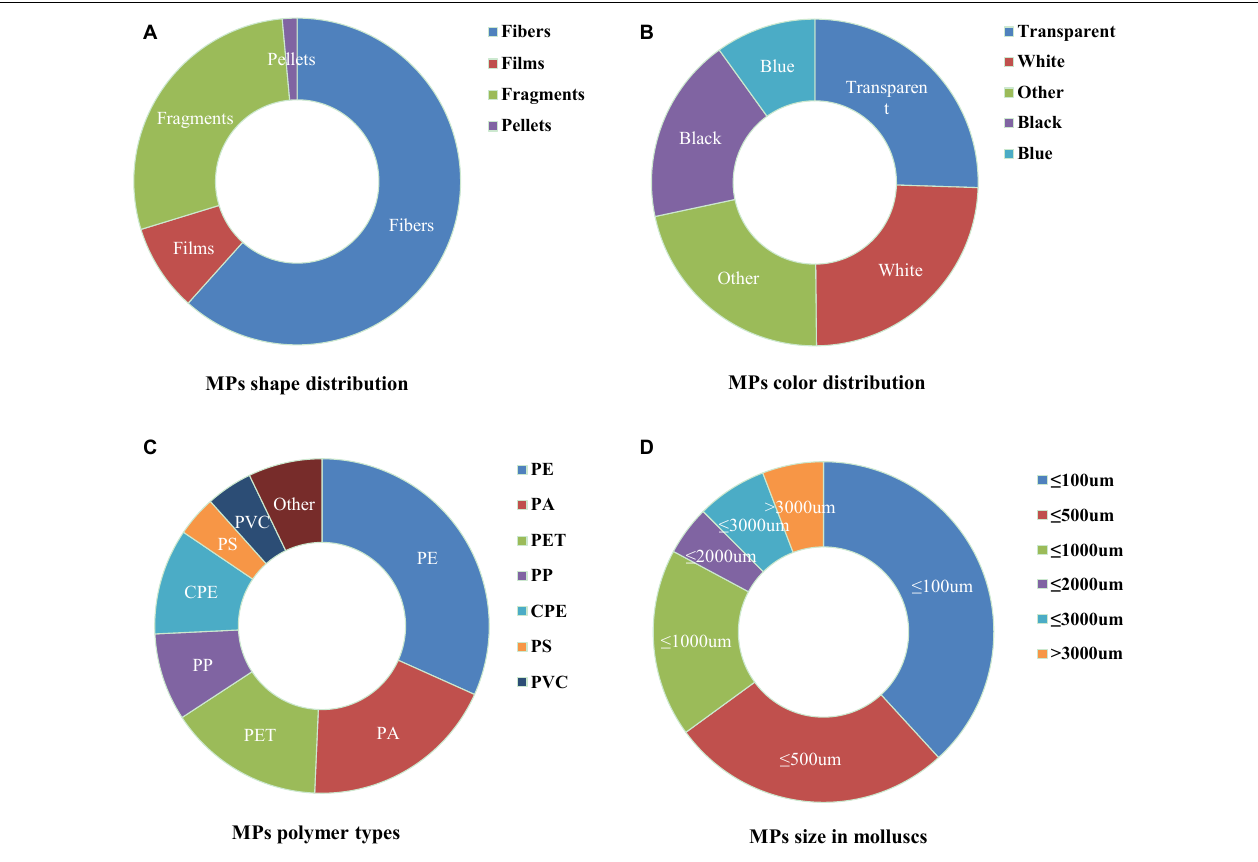
FIGURE 1 | Composition profiles (shape, color, polymer type, and size) of microplastics (MPs) in mollusks. (A) Description of shape is contained in the first panel; (B) Description of color is contained in the second panel; (C) Description of polymer type is contained in the Third panel; (D) Description of size is contained in the fourth